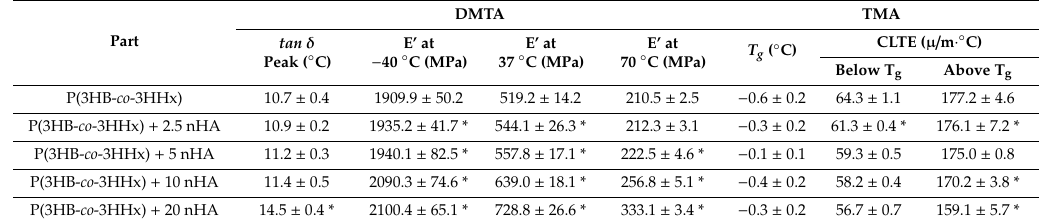
Thermomechanical properties of the injection-molded poly(3-hydroxybutyrate- co -3-hydroxyhexanoate) [P(3HB- co -3HHx)] / hydroxyapatite nanoparticles (nHA) parts in terms of dynamic